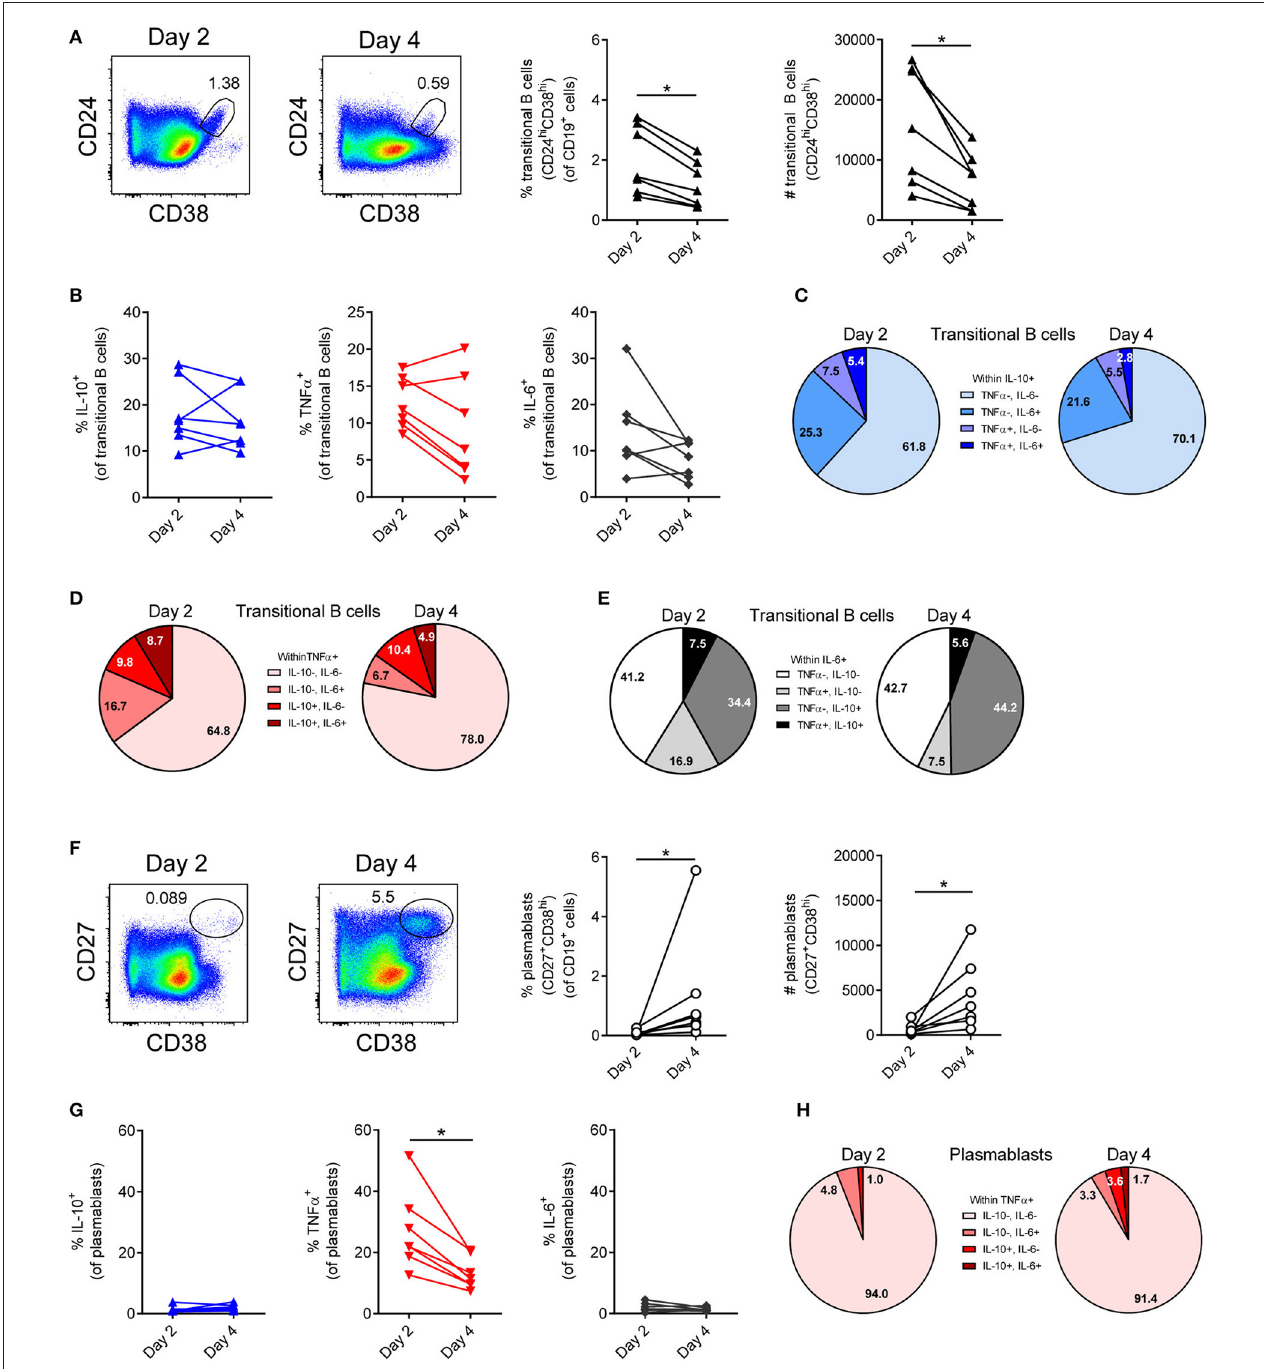
FIGURE 2 | IL-10, TNF α , and IL-6 production by transitional B cells and plasmablasts after B cells were stimulated with CpG. (A,F) Frequency and number of transitional B cells (A) and plasmablasts (F) were quantified 2 and 4 days after B cells were stimulated with 1.25 µ M CpG ( n = 7). Representative dot plots are depicted. Each dot/line represents 1 donor. (B,G) Frequency of cytokine-producing cells within transitional B cell (B) and plasmablast populations (G) ( n = 7). (C–E) Relative distribution of (C) IL-10 + TNF α − IL-6 − (light blue), IL-10 + TNF α − IL-6 + (blue), IL-10 + TNF α + IL-6 − (lavender blue), IL-10 + TNF α + IL-6 + (dark blue) B cells within IL-10 + transitional B cells; (D) IL-10 − TNF α + IL-6 − (pink), IL-10 − TNF α + IL-6 + (light red), IL-10 + TNF α + IL-6 − (red) and IL-10 + TNF α + IL-6 + (bordeaux) B cells within TNF α + transitional B cells; (E) IL-10 − TNF α − IL-6 + (white), IL-10 − TNF α + IL-6 + (light gray), IL-10 + TNF α − IL-6 + (gray) and IL-10 + TNF α + IL-6 + (black) B cells within IL-6 + transitional B cells stimulated with 1.25 µ M CpG at different time points ( n = 7). (H) Relative distribution of IL-10 − TNF α + IL-6 − (pink), IL-10 − TNF α + IL-6 + (light red), IL-10 + TNF α + IL-6 − (red) and IL-10 + TNF α + IL-6 + (bordeaux) B cells within TNF α + plasmablasts stimulated with 1.25 µ M CpG ( n = 7). Wilcoxon tests were performed. * p <